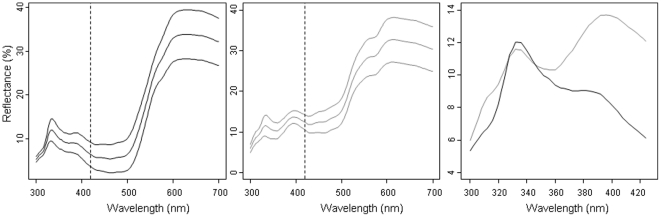
Ventral reflectance spectra.Mean (±SD) ventral spectra of Lissotriton vulgaris (left) and L. helveticus (center) tested in the experiment. Close-up on the UV range that shows the two peaks in Lissotriton vulgaris (black line) and L. helveticus (grey line) in the UV range. The dotted lines indicate the limit of the UV range.